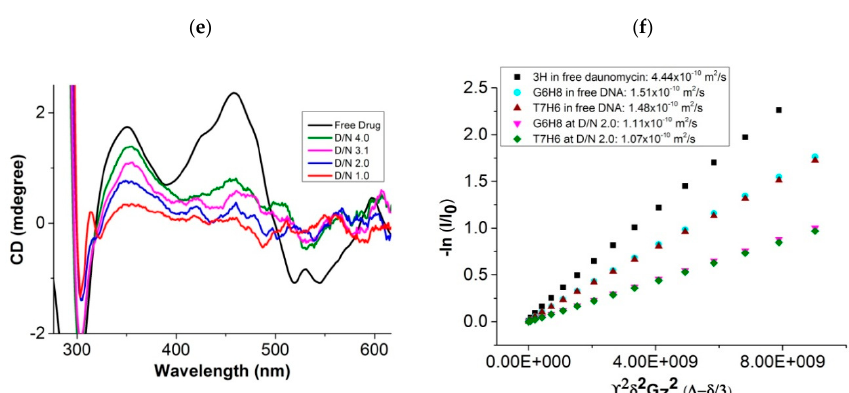
Figure 2. ( a ) Results of surface plasmon resonance experiments for the binding of daunomycin to [d- (TTGGGGT)] 4 . Sensograms obtained for free daunomycin concentration from 30 μ M (bottom) to 960 μ M (top), using HEPES buffer with 100 mM of KCl at 25 °C; ( b ) Binding plot of steady-state response (R.U.) versus concentration of daunomycin ( μ M); ( c ) Job Plot for binding of daunomycin to [d- (TTGGGGT)] 4 showing a difference in the fluorescent intensity of bound and unbound daunomycin as a function of the mole fraction of daunomycin. The total concentration of daunomycin and [d- (TTGGGGT)] 4 was kept constant as 7 μ M in 10 mM of phosphate buffer (KBPES) containing 100 mM of KCl at 25 °C; ( d ) Circular dichroism spectra of 15 μ M of free [d-(TTGGGGT)] 4 and its complex at Daunomycin (D) to Nucleic acid (N) ratio, D/N = 1.0, 2.0, 3.0, and 4.0; ( e ) Circular dichroism spectra of 400 μ M of free daunomycin and its complex with [d-(TTGGGGT)] 4 at D/N = 1.0, 2.0, 3.0, and 4.0 in 10 mM of phosphate buffer containing 100 mM of KCl at 25 °C; and ( f ) Diffusion coefficient measurement obtained from Diffusion Ordered SpectroscopY (DOSY) spectra of free daunomycin, free [d-(TTGGGGT)] 4 , and daunomycin-[d-(TTGGGGT)] 4 complex at D/N = 2.0 at 25 °C.